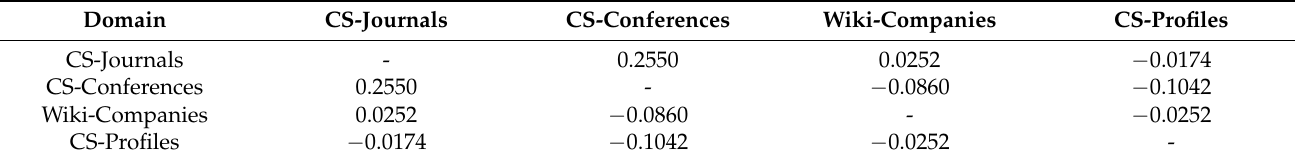
Table 2. The correlation coefficient matrix of the feature function f(x = (1 <# OfWords <= 10) && y = C). Domain